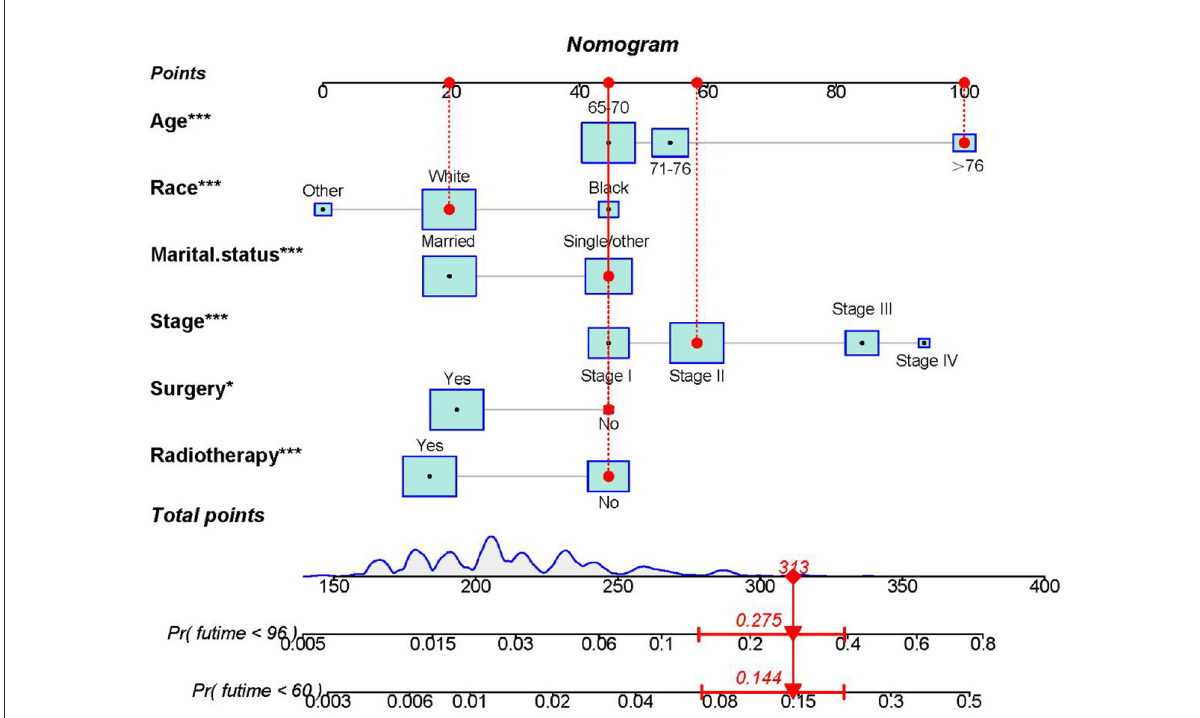
FIGURE2 The nomogram was constructed to predict the 5- and 8-year HDSS in older female primary breast cancer patients that underwent chemotherapy. To calculate the HDSS of an individual patient, point values for each prognostic predictor were obtained by drawing a straight line to the top point row. Next, the corresponding point values were summed to get the total score below. The 5- and 8-year HDSS were obtained by drawing vertical lines from the total score row to the bottom timeline. For example, for an 80-year-old unmarried white race female patient with stage II disease that did not undergo surgery or radiotherapy, the total score is 100 (80 years old) + 20 (white race) + 45 (single/other) + 58 (stage II) + 45 (no surgery) + 45 (no radiotherapy) = 313, and the corresponding risk of heart disease-associated death at 5- and 8-year are 0.144 and 0.275, while the corresponding HDSS of the patient at 5- and 8-year are 0.856 and